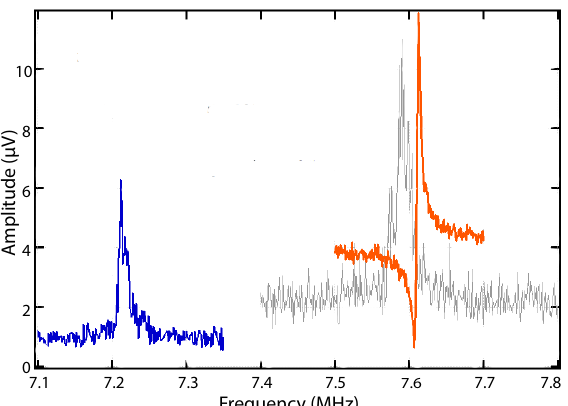
Figure 7. Resonance peaks of the B9 device in vacuum conditions. Gray color shows the thermomechanical peak for the untrimmed device at room temperature. Blue color is the thermomechanical peak for the trimmed device at room temperature. Orange color represents the driven peak of the untrimmed device at 50 mV at 18.25 K.